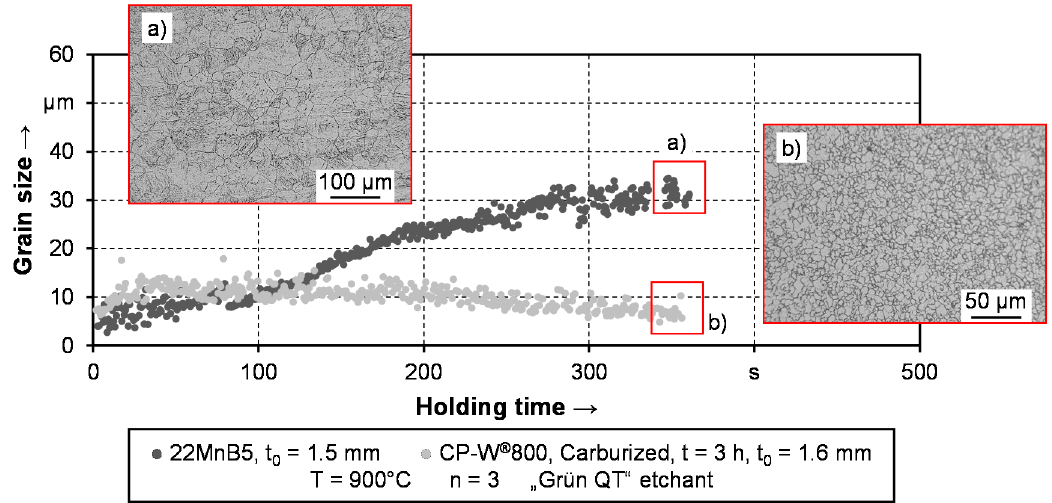
Figure 11. Grain growth of carburized complex phase steel and 22MnB5. The figure includes micrographs of the etched grain size of ( a ) 22MnB5 and ( b ) the carburized complex phase steel .